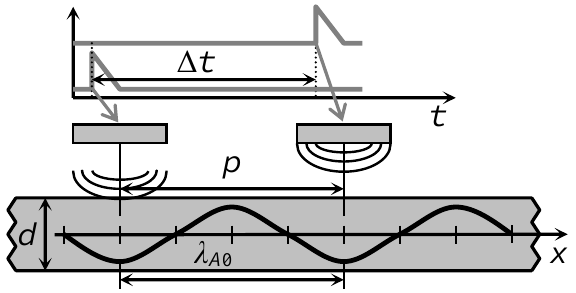
Figure 5. Principle of air-coupled A 0 Lamb wave mode excitation using phased array with rectangular elements, when the phase velocity is lower than ultrasound velocity in air.